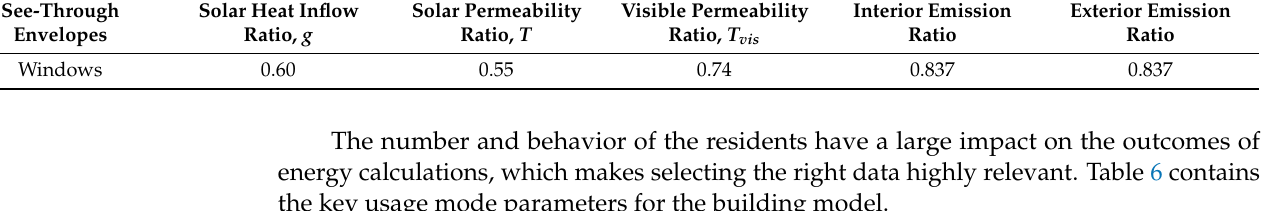
Table 5. Data of see-through building Table 4. Envelope areas of the modeled building.